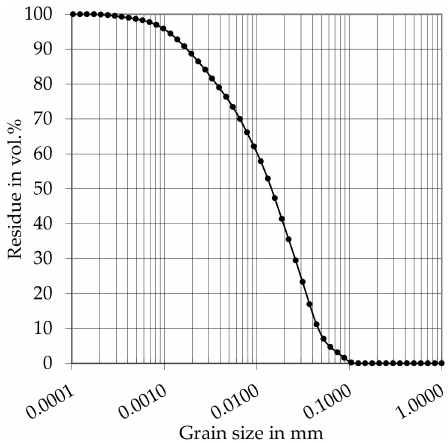
Figure 4. Grain size distribution of the used OPC.